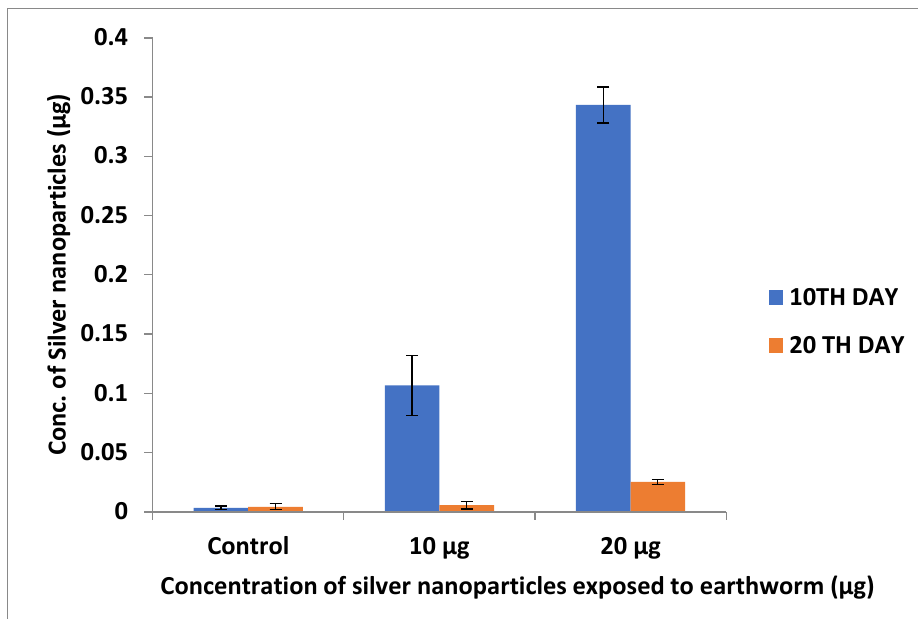
Figure 9. Silver nanoparticle accumulation study using ICP–OES in